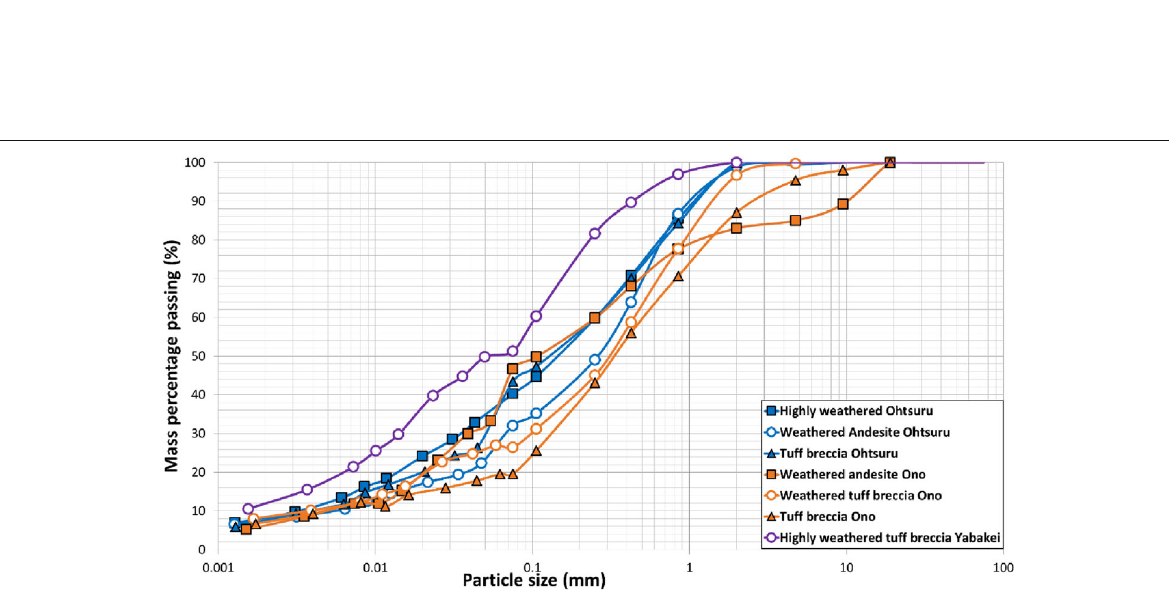
Fig. 10 Particle size distribution curves of soil